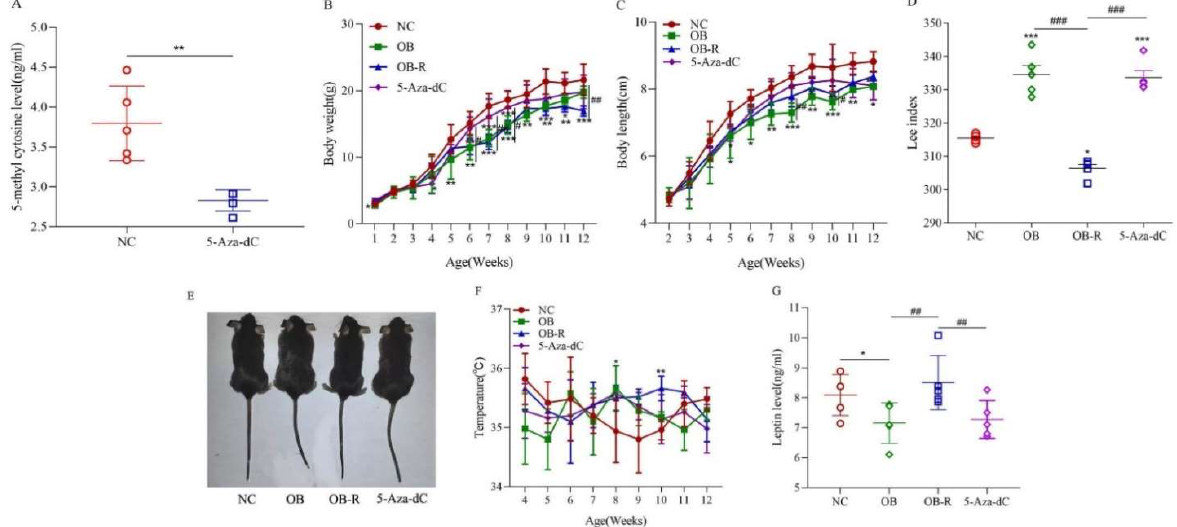
Figure 2. The effect of 5-Aza-dC on the growth characteristics of mice. ( A ) Identification of 5-methyl cytosine levels after 5-Aza-dC treatment, presented as the mean ± SD (n = 5). ( B ) Body weights in the NC, OB, OB-R, and 5-Aza-dC groups from weeks 1 to 12 are presented as the mean ± SD (n = 5). ( C ) Body lengths of mice in the four groups from weeks 2 to 12 are presented as the mean ± SD (n = 5). ( D ) Lee indices in the four groups at week 12 are presented as the mean ± SD (n = 5). ( E ) Four mice from the same litter; the first shows the general appearance of a normal mouse, the second shows an obese mouse, the third shows an obesity-resistant mouse, and the fourth shows a 5-aza-2′-deoxycytidine-induced mouse. ( F ) Body temperatures in the three groups from weeks 4 to 12 are shown as the mean ± SD (n = 5). ( G ) Levels of the four groups’ leptin levels in mouse serum are presented as the mean ± SD (n = 5). * p < 0.05; ** p < 0.01; *** p < 0.001 vs. the NC group; # p < 0.05; ## p < 0.01; ### p < 0.001, compared with each other. NC, normal control; OB, MSG-induced obese